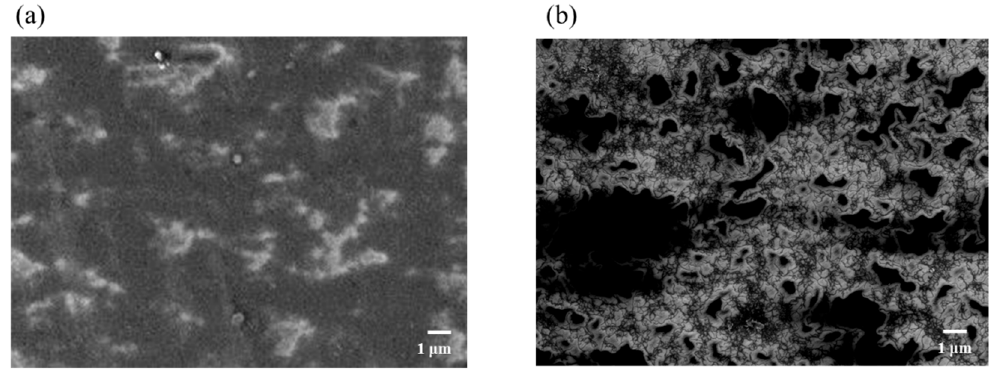
Figure 3. FE-SEM images of ( a ) F COMP ( b ) F CNT .